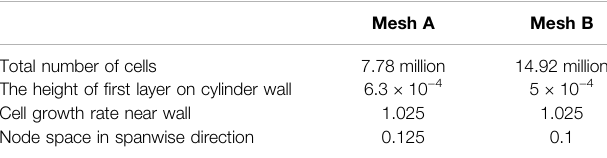
TABLE 1 | Parameters of grid